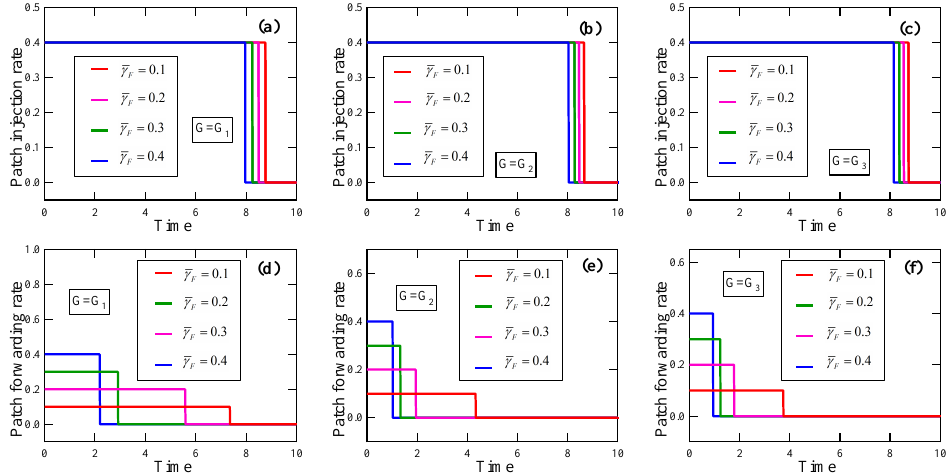
Figure 13. The experimental results in Experiment 2 about the effect of the maximum allowable patch forwarding rate on the optimal patching strategy. ( a ) Patch injection rate, G = G 1 ; ( b ) Patch injection rate, G = G 2 ; ( c ) Patch injection rate, G = G 3 ; ( d ) Patch forwarding rate, G = G 1 ; ( e ) Patch forwarding rate, G = G 2 ; ( f ) Patch forwarding rate, G = G 3